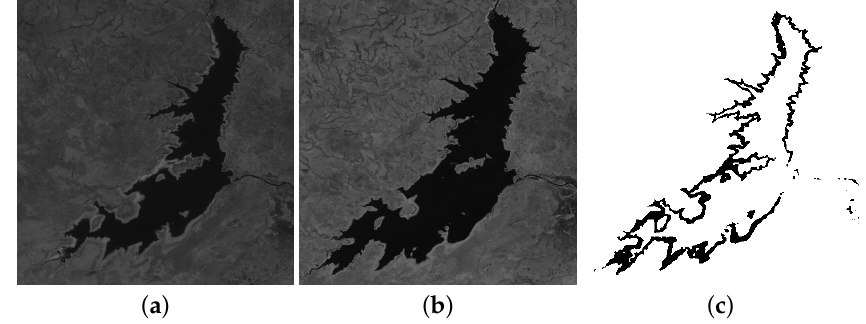
Figure 3. Band 2 of the multitemporal images of Itezhi Tezhi Dam, Zambia ( a ) acquired on 30 September 1995, ( b ) acquired on 4 July 1998, and ( c ) Reference Change Map (Ground truth).